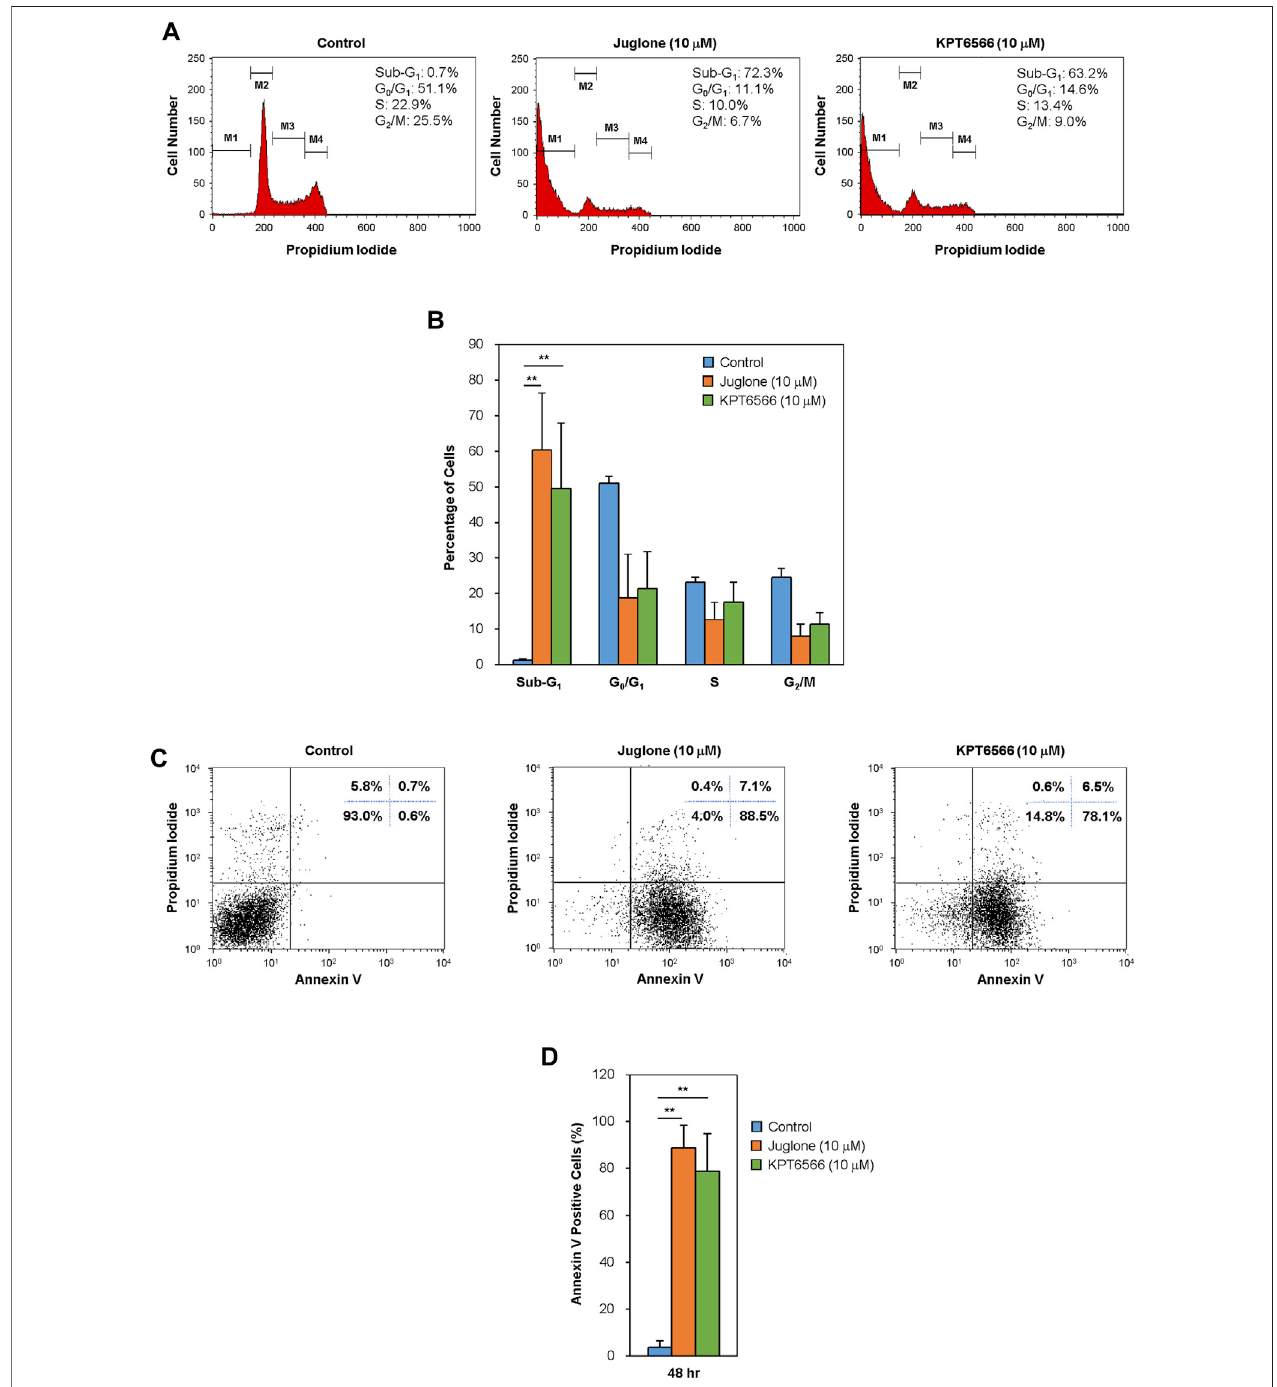
FIGURE4| EffectofJugloneandKPT6566onapoptosisofCaco-2cells invitro . (A) FlowcytometryanalysisofthecellcycledistributionofCaco-2cellsaftertreatment withJugloneorKPT6566.Caco-2cellswereculturedfor48 hinthepresenceofJugloneorKPT6566,andDNAcontentwasdeterminedbymeasuring fl uorescenceafterPI staining using a fl ow cytometer. M1, M2, M3, and M4 represent gated Sub-G 1 , G 0 /G 1 , S, and G 2 /M populations. Representative histograms of cellcycle distribution depict apoptosis in Juglone- or KPT6566-treated Caco-2 cells. Five independent experimentsyielded similar results. (B) Analysis of the percentageof cells at each cellcycle phase.The percentageoftotal cells insub-G 1 , G 0 /G 1 , S,and G 2 /Mphase was calculatedusing FlowJosoftware. Eachcolumn representsthe mean ± S.D.for eachgroup. ** p < 0.01, compared with the control group ( n = 5). (C) Detection of cell apoptosis in Caco-2 cells by Annexin V-PI staining assay. Caco-2 cells were treated with 10 μ M JugloneorKPT6566,stainedwithFITC-AnnexinV-PI,andanalyzedby fl owcytometry. (D) QuantitativeanalysisofJuglone-orKPT6566-inducedapoptosis.Apoptoticratios for each group are presented as the mean ± S.D. ** p < 0.01 versus control group ( n = 3).